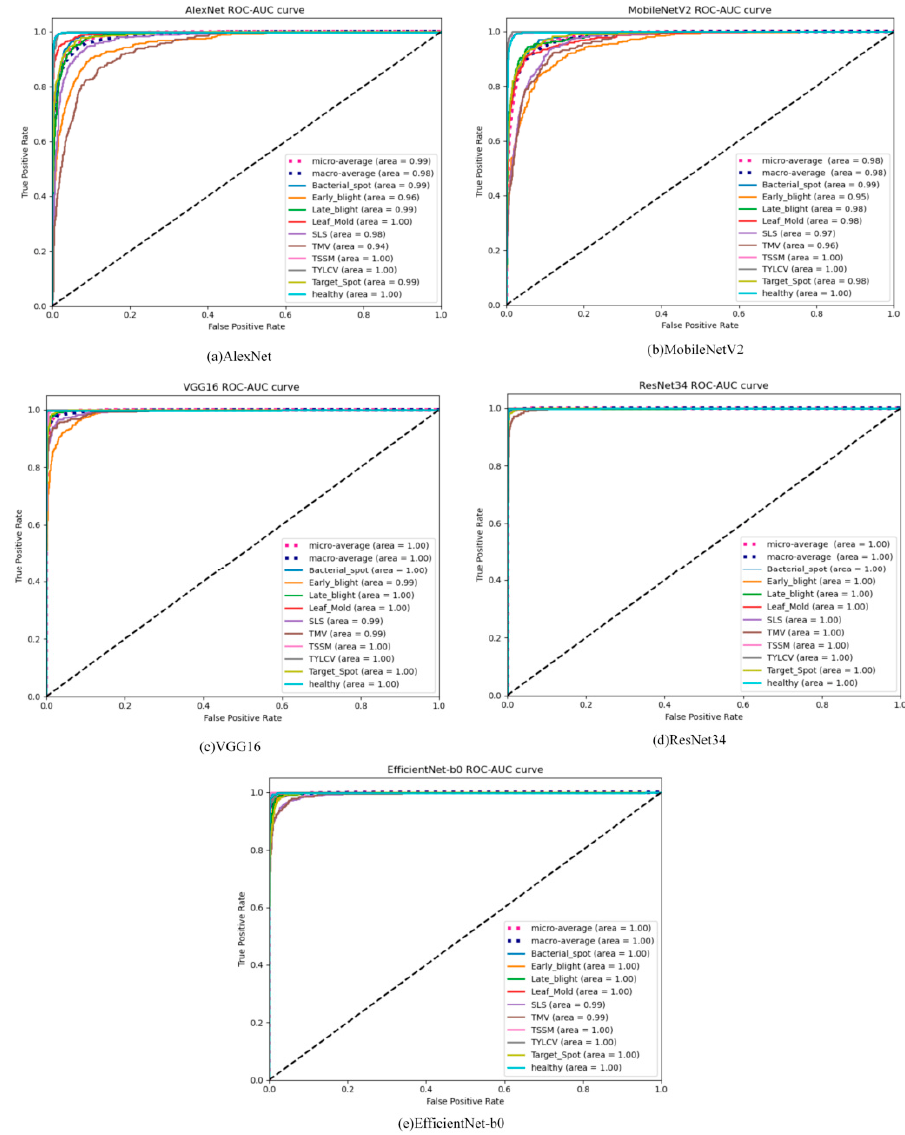
Figure 8. ROC curves of tested deep learning algorithms.